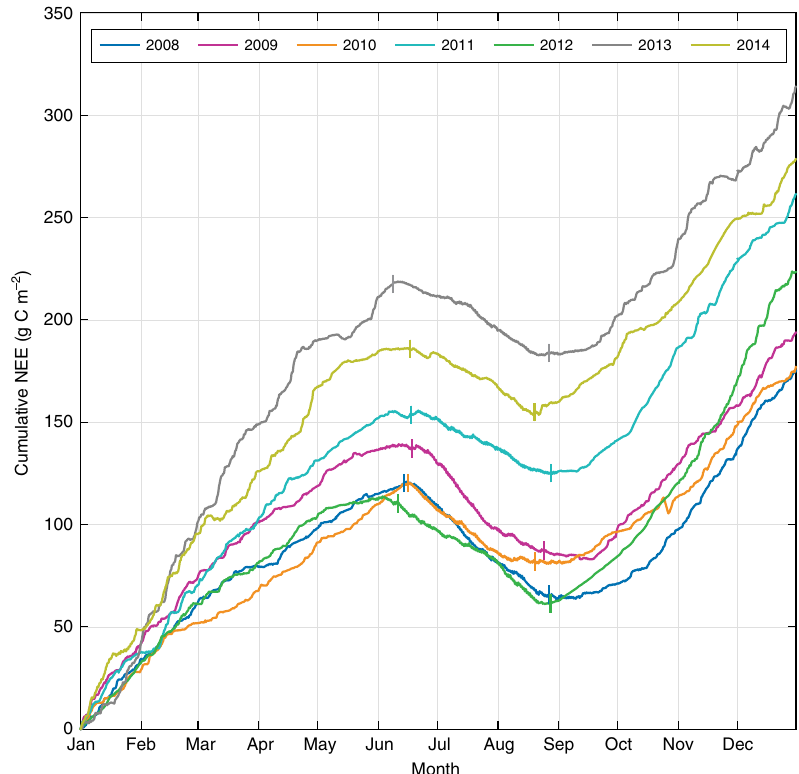
Fig. 2 The alpine tundra was annually a net source of carbon to the atmosphere. The interannual variability of cumulative NEE of carbon dioxide between 2008 and 2014, shown as the equivalent grams of carbon per square meter. A positive slope denotes net carbon loss to the atmosphere and vertical dashes mark the beginning and end of each growing season determined as the average of three methodological techniques 39